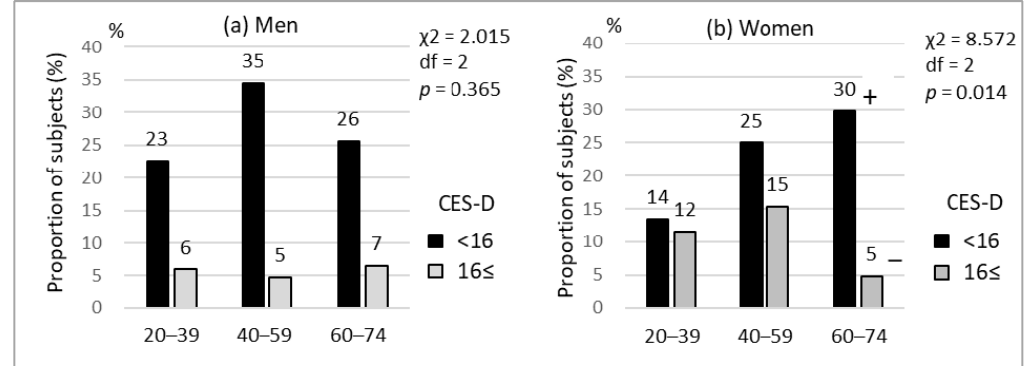
Figure 1. The percentage of subjects with depressive symptoms in each age group: ( a ) Analysis of men; ( b ) Analysis of women. Three age groups (20–39, 40–59, and 60–74) were compared by the chi-square test and subsequently by post hoc adjusted residual analysis. + ; adjusted residual > 1.96, − ; adjusted residual < − 1.96.